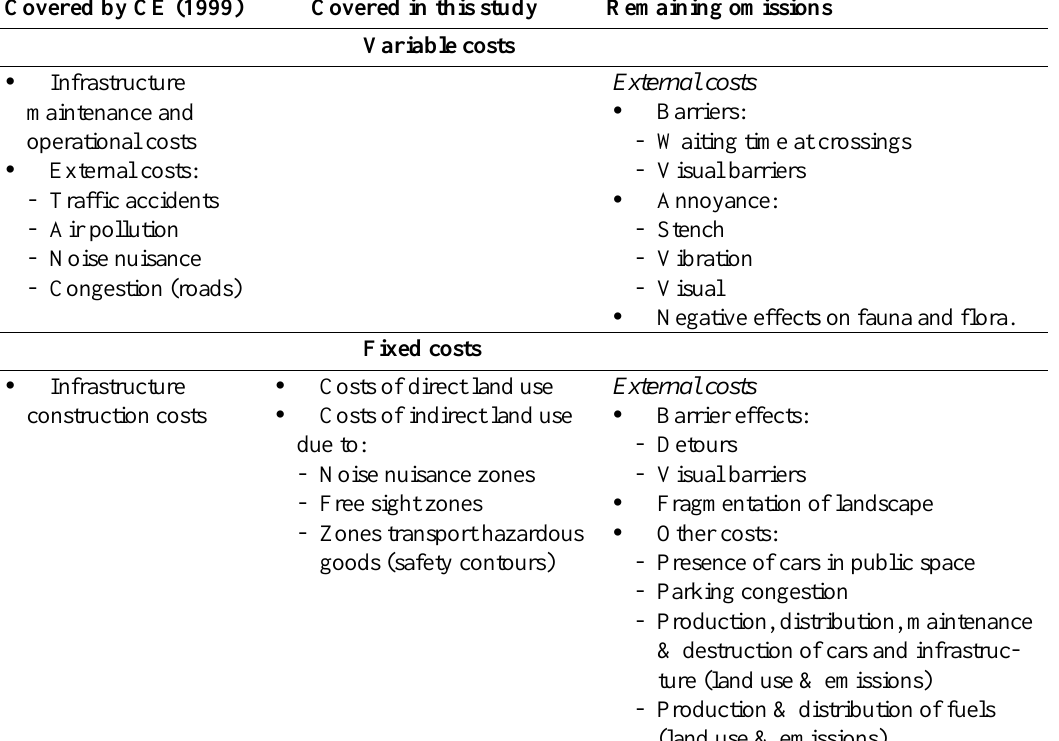
Table 1. Overview of social costs of transport and infrastructure Covered by CE